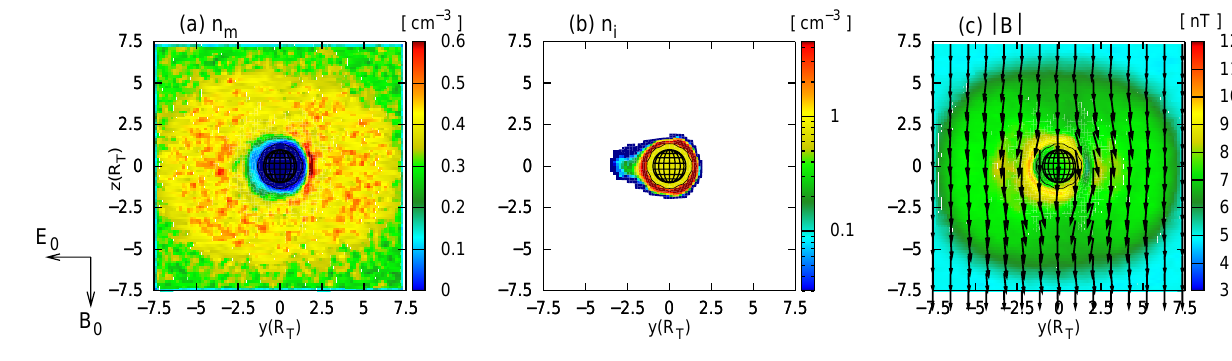
Fig. 6. Interaction of Titan’s ionosphere with a supersonic plasma flow – results of a 3-D hybrid simulation. The figure displays the simulation results for a cut through the (y,z) plane of the simulation domain, coinciding with the terminator plane of the obstacle. The undisturbed plasma flow is directed in positive x direction, i.e. out of the paper plane, whereas the undisturbed magnetic field is orientated antiparallel to the z axis. The figure shows (a) the mean (N + /H + ) plasma density, (b) the ionospheric plasma density and (c) the magnetic field. The color scale denotes the field strength, whereas the arrows indicate the projection of the magnetic field vectors on the cutting plane. Due to the upstream plasma flow being supersonic, a bow shock arises in front of the obstacle. Since the phase velocity of the fast magnetosonic mode is not isotropic, but depends on the angle between wave propagation and the magnetic field, the shock structure in the terminator plane is not circular. The elliptic structure of the bow shock is clearly identifiable in the magnetic field signature, cf. (c).